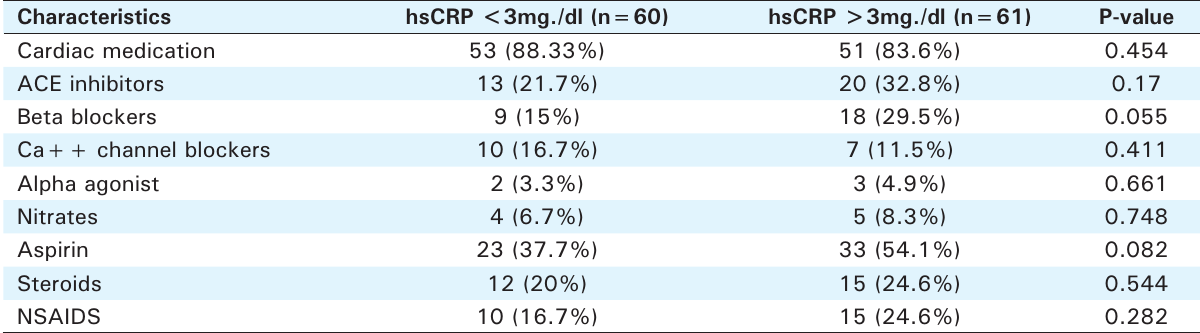
Table 2. Comparison of preoperative medication among the study subjects grouped according to hsCRP level < or>